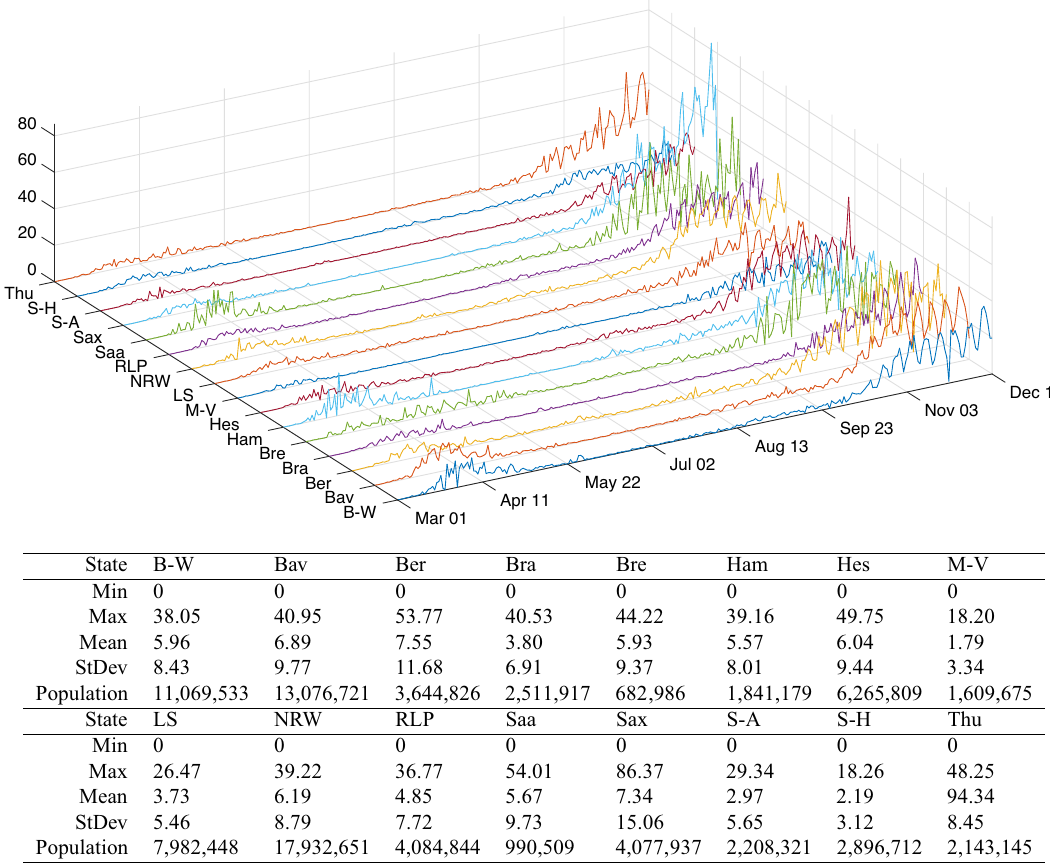
Figure 1. Daily COVID-19 cases per 100,000 inhabitants from all 16 states in Germany from March 01 until December 15, 2020: B-W (Baden-Württemberg), Bav (Bavaria), Ber (Berlin), Bra (Brandenburg), Bre (Bremen), Ham (Hamburg), Hes (Hesse), M-V (Mecklenburg-Vorpommern), LS (Lower Saxony), NRW (North Rhine- Westphalia), RLP (Rhineland-Palatinate), Saa (Saarland), Sax (Saxony), S-A (Saxony-Anhalt), S-H (Schleswig- Holstein), Thu (Thuringia). Population data come from the 2018 census by the Federal Statistical Office of Germany 63